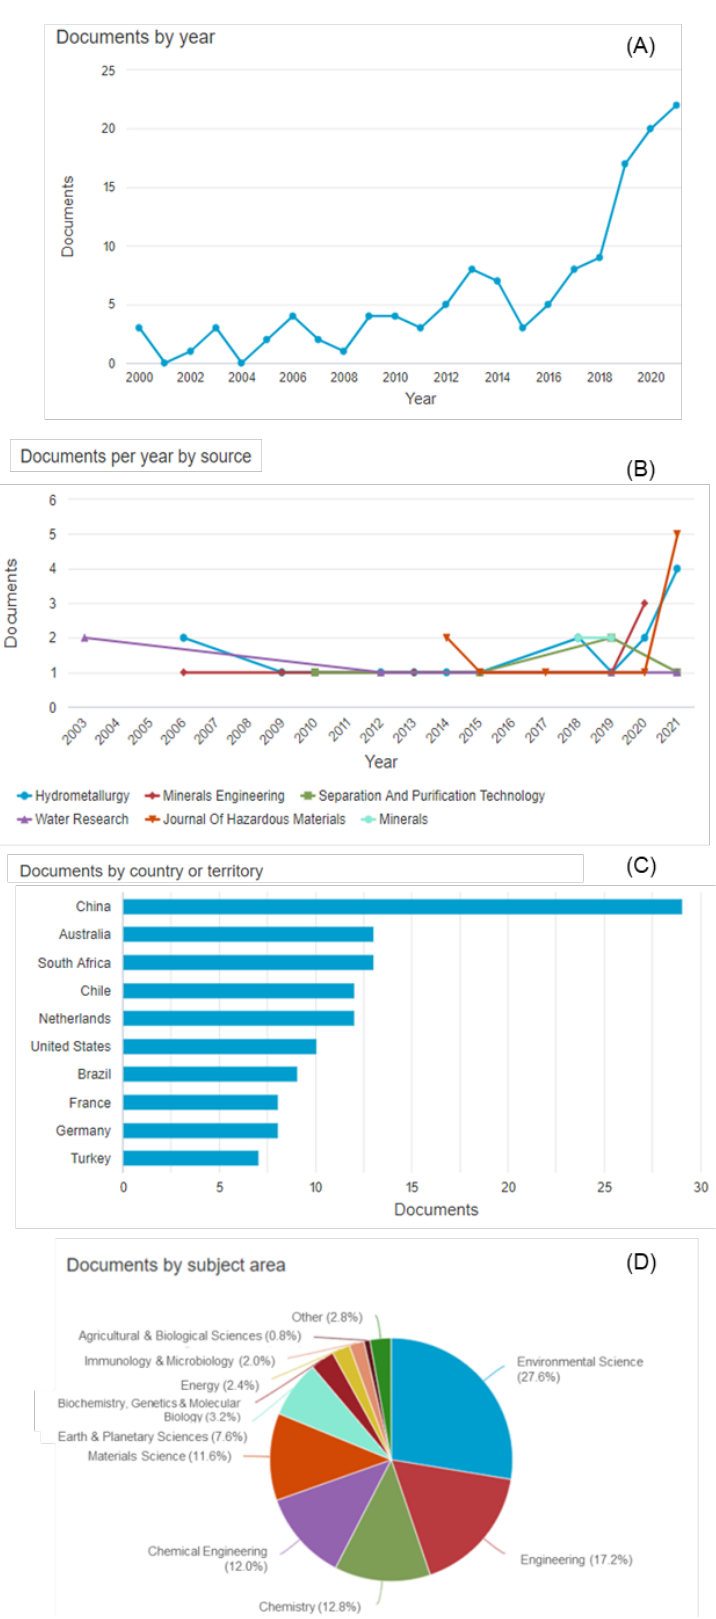
Figure 1. Results from the scientometric analysis, period 2000–2021. ( A ) Documents per year, ( B ) Documents by source (journal), ( C ) Documents by the top 10 countries, and ( D ) Documents by subject area.